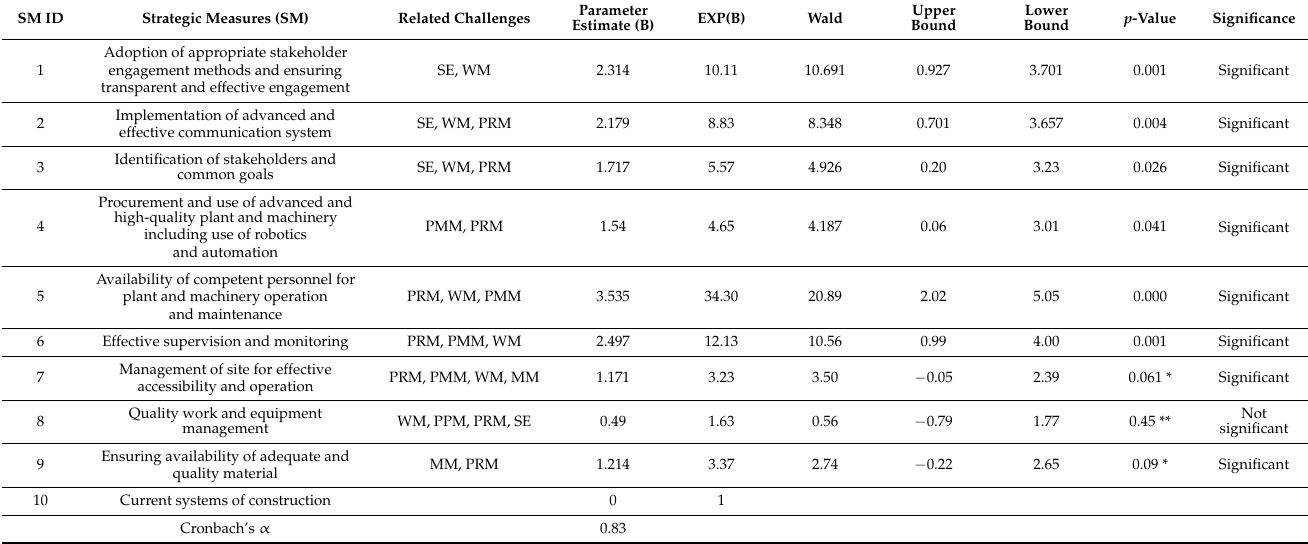
Table 7. Strategic measures for construction site management during